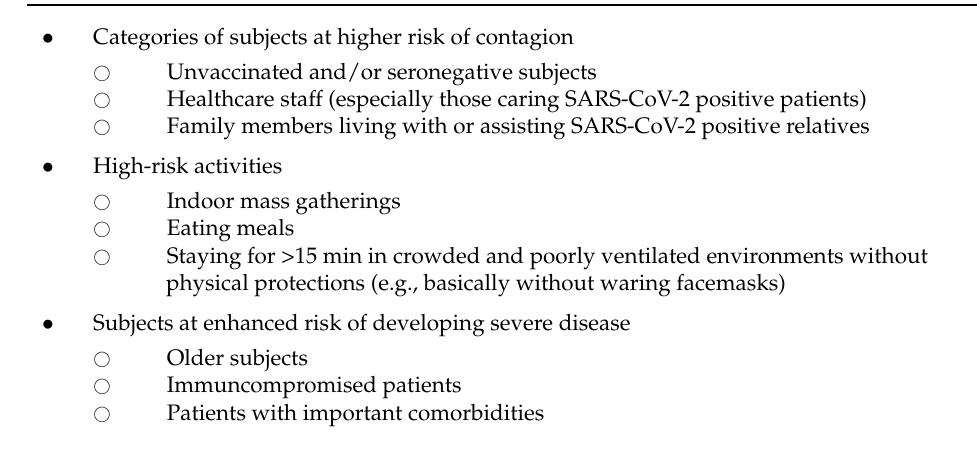
Table 1. The preferential usage of nasal sprays for preventing SARS-CoV-2